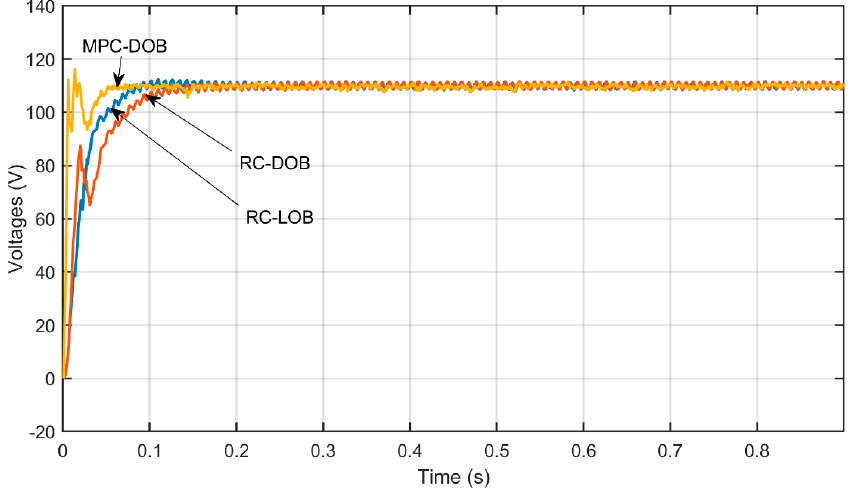
Figure 15. Transient response of MPC-DOB, RC-DOB, and RC-LOB under the nonlinear load.